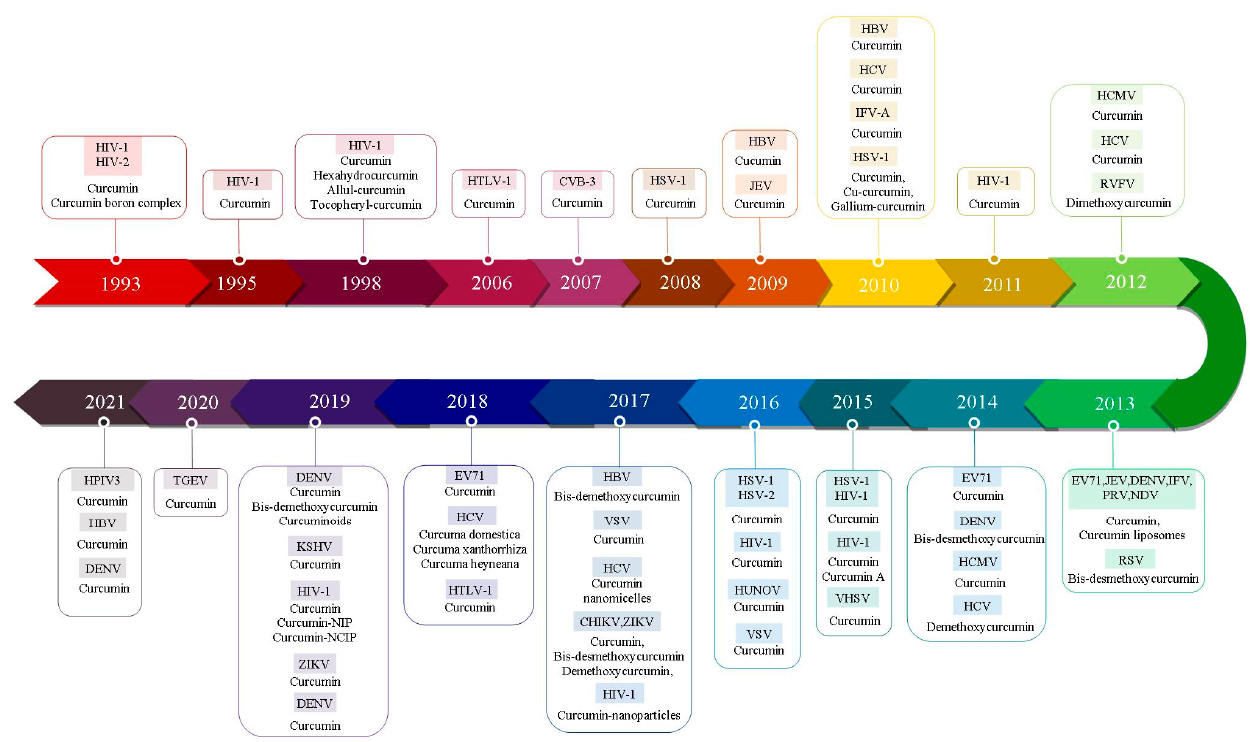
Figure 1. Timeline of development of curcumin therapy against different types of human viruses: IAV, influenza A virus; PIV-3, parainfluenza virus 3; ZIKA, Zika; CHIKV, Chikungunya virus; JEV, Japanese encephalitis virus; EV71, enterovirus 71; HCV, hepatitis C virus; VSV, vesicular stomatitis virus; EV, Ebola virus; RSV, respiratory syncytial virus; HIV, human immunodeficiency virus; HTLV-1, human T-lymphocyte virus; RVFV, Rift Valley fever virus; HuNoV, human norovirus; CVB3, coxsackievirus B3; TGEV, transmissible gastroenteritis virus; HBV, hepatitis B virus; HSV, herpes simplex viruses; HCMV, human cytomegalovirus; EBV, Epstein–Barr virus.